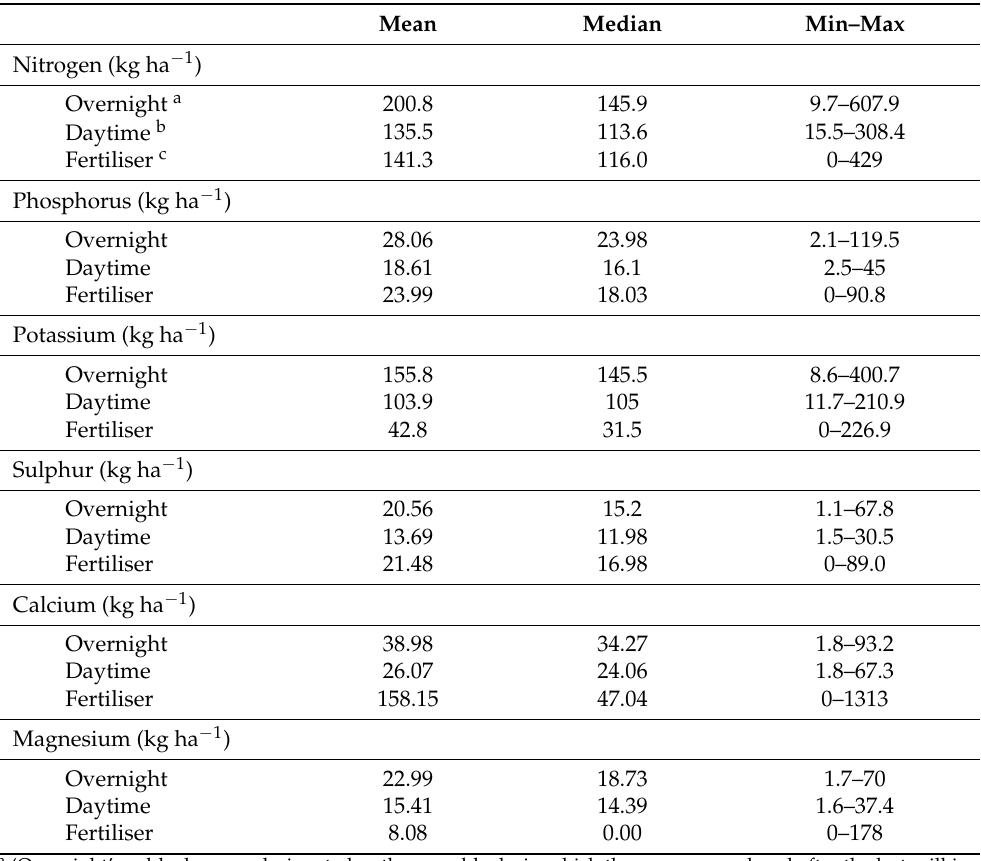
Table 9. Summary statistics (mean, median, range) for nutrient loading rate (kg ha − 1 ) excreted over a lactation (305 days) by the lactating herds in ‘overnight’ and ‘daytime’ paddocks, as well as for nutrients applied as fertilisers, on 42 grazing system dairy